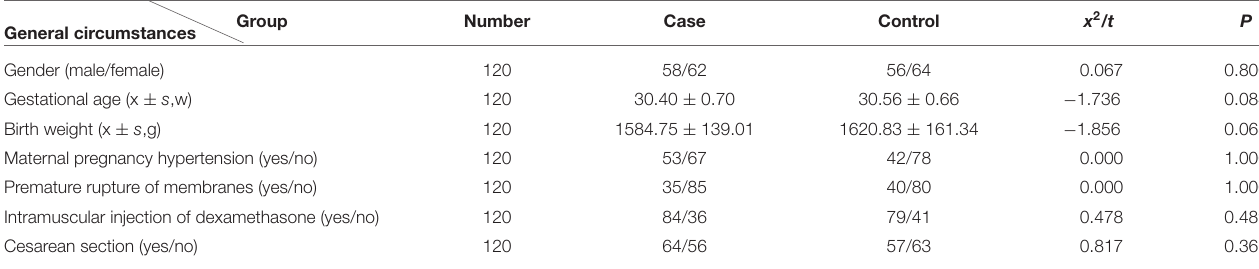
TABLE 1 | Comparison of general data of the case-control